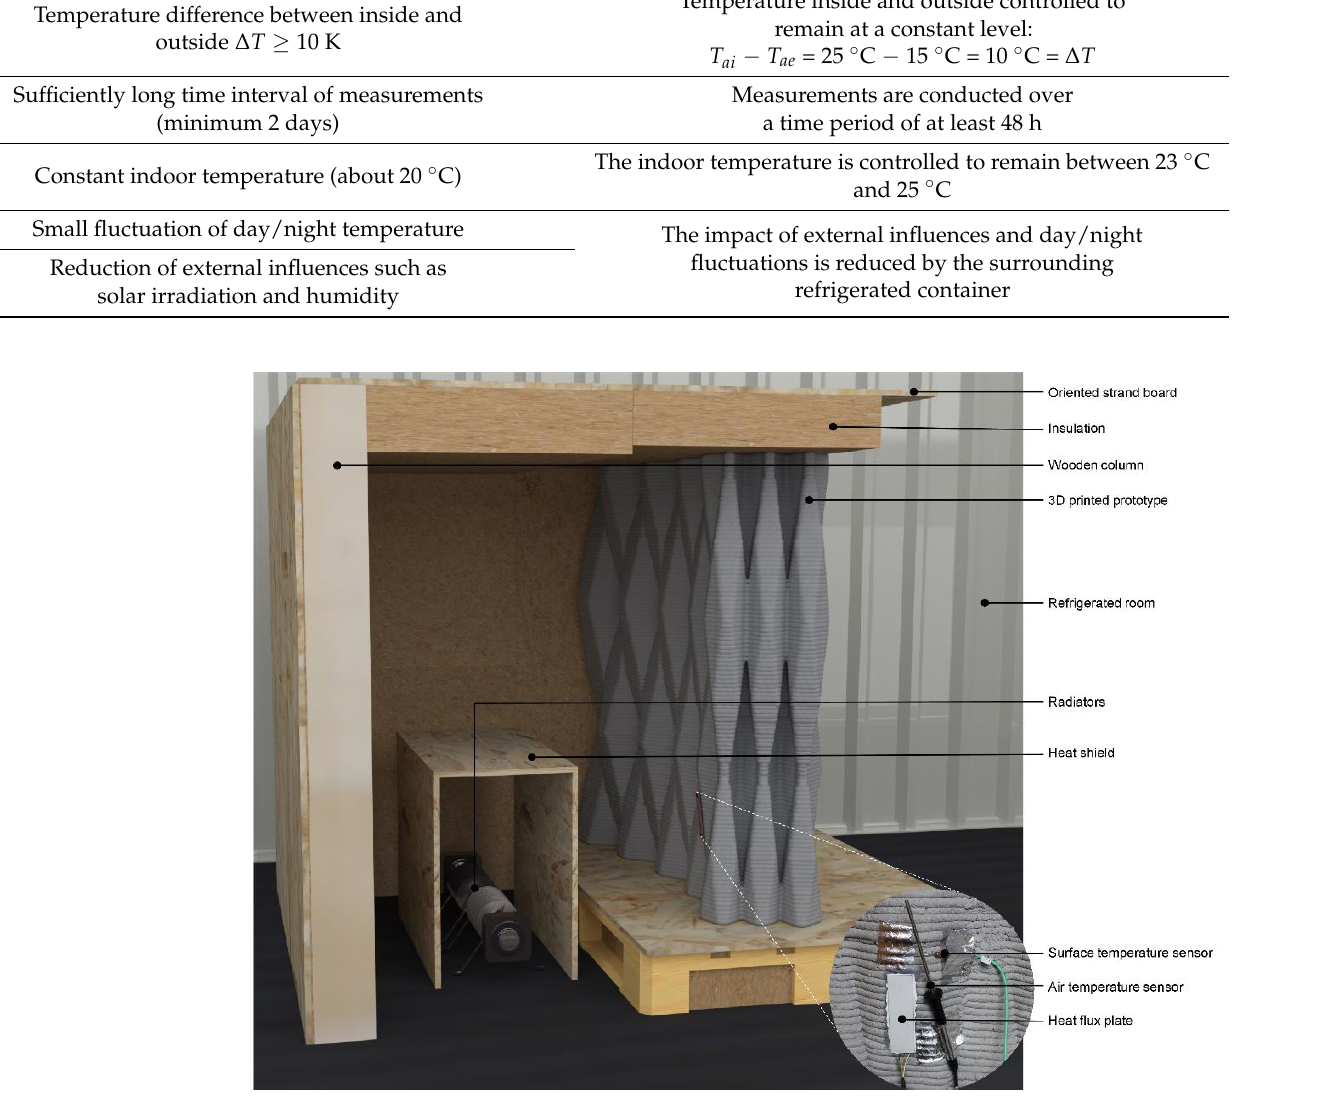
Figure 5. Visualization of the experimental setup for in situ heat flux measurements on an AM light- weight concrete wall element with a close-up of the sensor